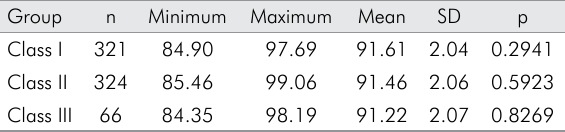
Table 2. Comparison of the overall ratio of each group with Bolton’s ratio (91.3 ± 1.91) by independent t test.